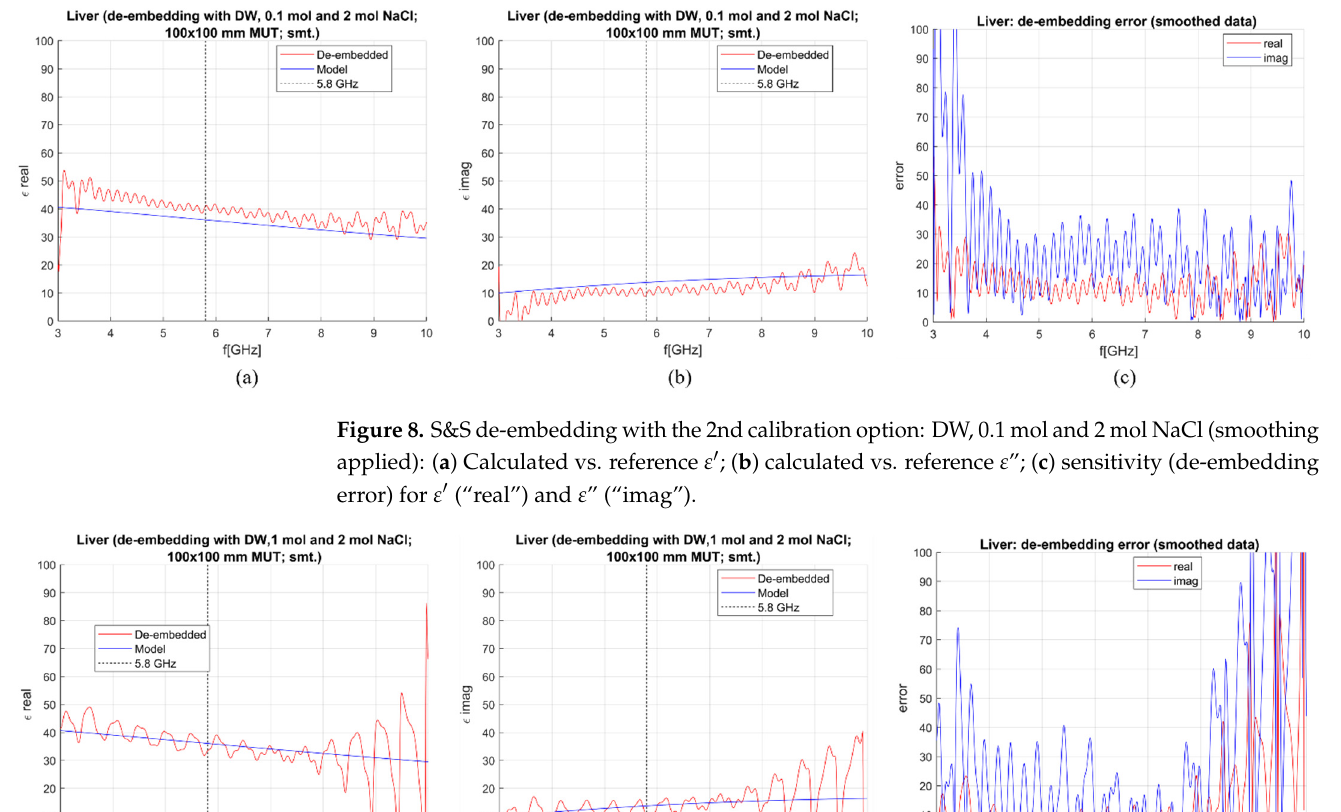
Figure 10. S&S de-embedding with the 4th calibration option: DW, 1 mol NaCl and EG70 (smooth- ing applied): ( a ) Calculated vs. reference ε ’; ( b ) calculated vs. reference ε ’’; ( c ) sensitivity (de-em- bedding error) for ε ’ (“real”) and ε ’’ (“imag”). The average sensitivity achieved in the frequency range of 3–10 GHz and at the op- erating frequency of 5.8 GHz for each calibration option is given in Table 3. De-embedded values with the first calibration option exhibit ripples in permittivity at higher frequencies. The second and third options give slightly better results in the imaginary part, but the de- embedded properties fluctuate a lot, most likely due to the too-close properties of the used calibration liquids. Finally, the de-embedding of the liver with the fourth calibration op- tion, which uses one NaCl solution and EG70, gives the best-averaged sensitivity in the frequency range of interest. Table 3. Averaged sensitivity in the 3–10 GHz range and at 5.8 GHz for S&S de-embedding with different calibration options.